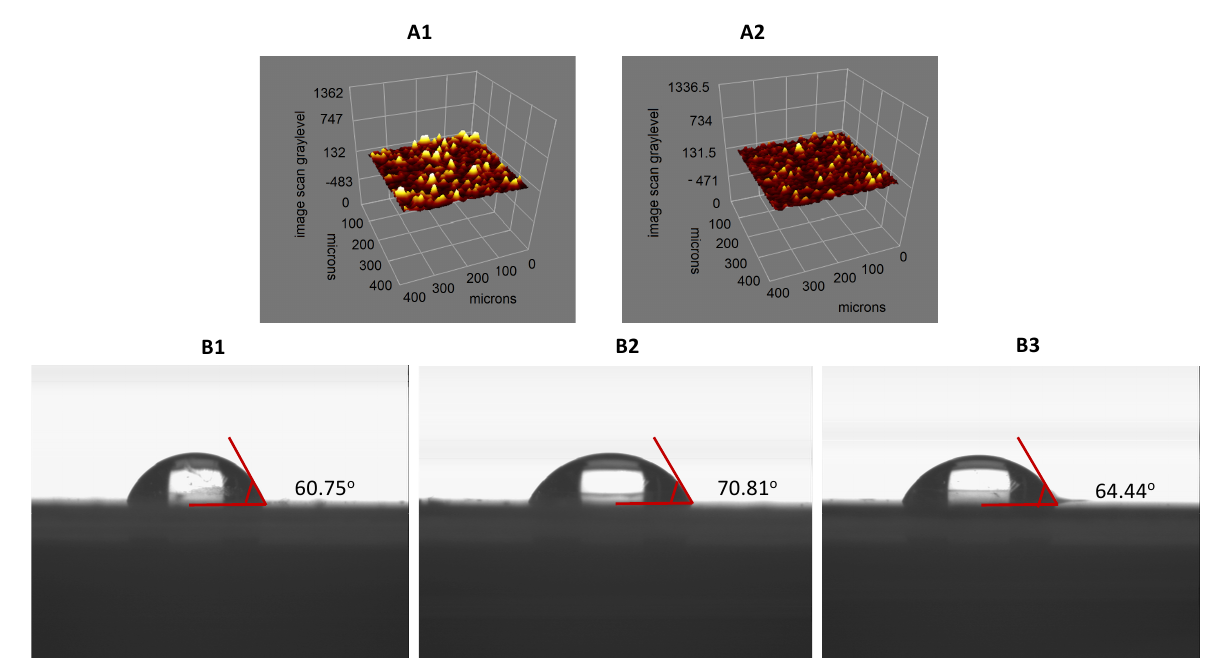
Figure 3. Morphology of bare gold surfaces and L -Phe imprinted SPR sensor surfaces (Ellipsometry images ( A1 : L -Phe imprinted SPR chip, A2 : non-imprinted SPR chip); contact angles ( B1 : bare gold SPR surface, B2 : L -Phe imprinted SPR chip, B3 : non-imprinted SPR